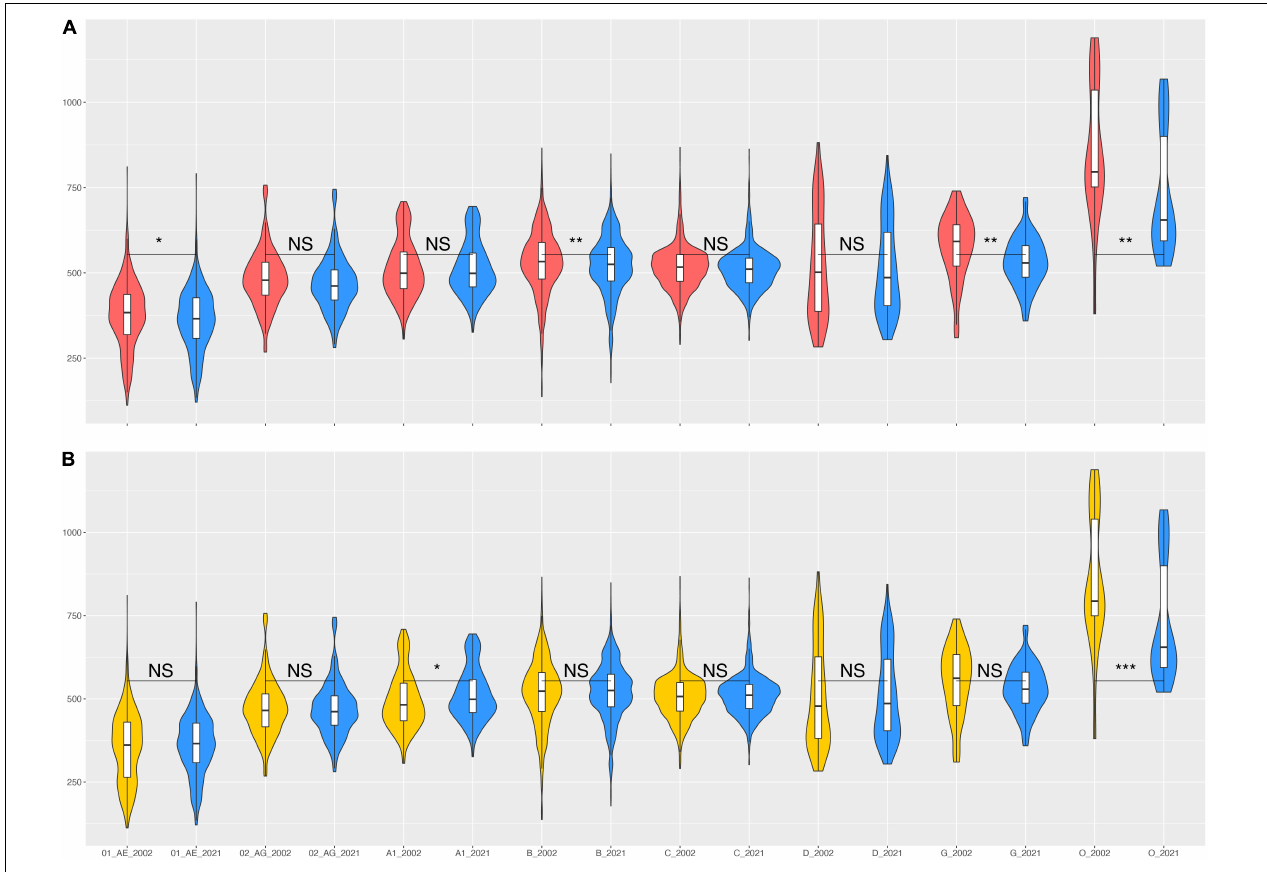
FIGURE 4 | Nucleotide state differences between HIV-1 consensus sequences and individual HIV-1 genomes from across the world. (A) Violin plots of the distribution of nucleotide state differences between individual HIV-1 sequences sampled up until 2002 and the 2002 consensuses (red) and individual HIV-1 sequences sampled up until 2021 and the 2021 consensuses (blue). (B) Violin plots of the distribution of nucleotide state differences between individual HIV-1 sequences sampled up until 2002 and the 2021 consensuses (yellow) and, again, individual HIV-1 sequences sampled up until 2021 and the 2021 consensuses (blue). Violin plot margins show the distribution of possible values, box margins 25% ( Q 1) and 75% ( Q 3) quantiles ( IQR ), box whiskers indicate Q 1 − 1 . 5 × IQR and Q 3 1 . 5 × IQR , the median is depicted by a horizontal line. Pairwise comparisons of the distributions show significance assessed by a two-sided Wilcoxon rank sum test with Bonferroni multiple-test correction ( p = α / m , with α = 0 . 05 ( * ), α = 0 . 01 ( ** ), α = 0 . 001 ( *** ) , and NS = not significant, for m = 16